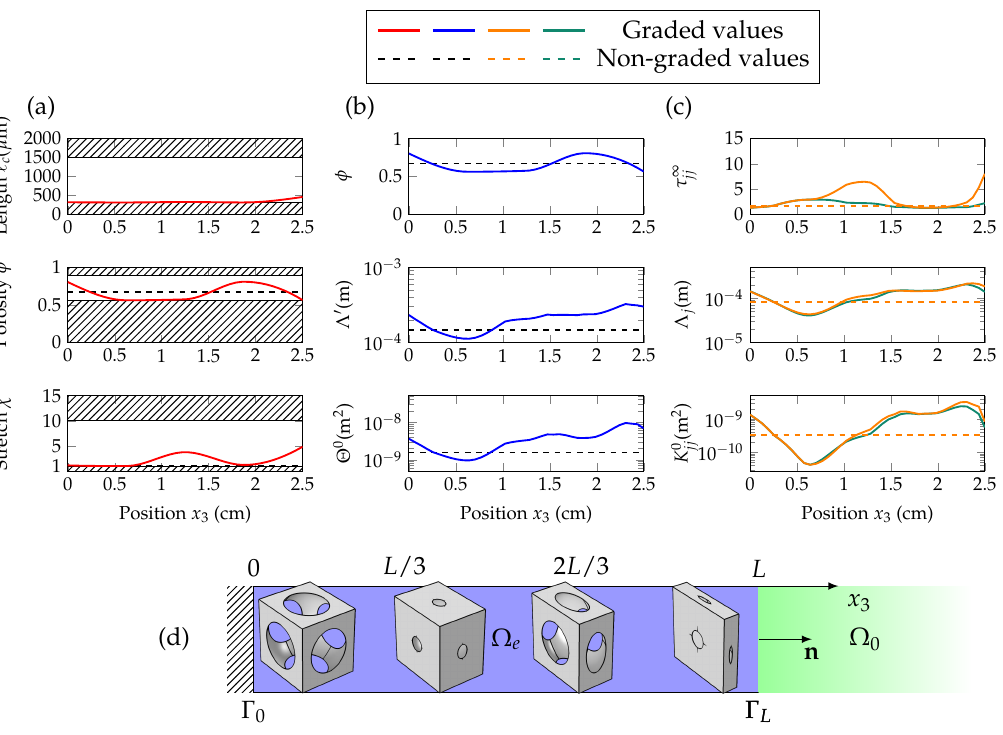
Figure 8. (Color online) Components of the vector of geometric parameters W g (characteristic length (cid:96) c , porosity φ and stretch χ ) are shown in ( a ), as a function of the position x 3 . Scalar JCAL parameters ( φ , Θ 0 , Λ (cid:48) ) are given in ( b ) and direction-dependent ones ( τ ∞ ⊥ , τ ∞ ( c ), with respect to x 3 . The graded values are in solid lines, and the non-graded ones in dashed lines; in orange for the normal direction, and in green for the transverse direction. The sketch in ( d ) displays snapshots of the unit cells at intervals of L /3 between interfaces Γ 0 and Γ L